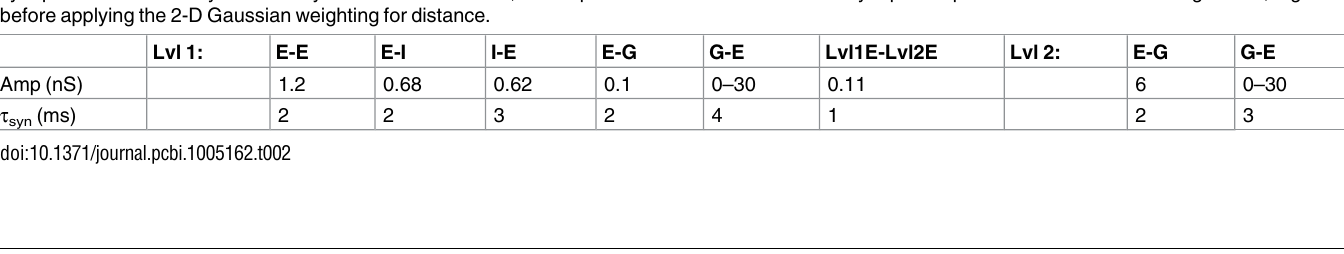
and σ were set to 2 i j